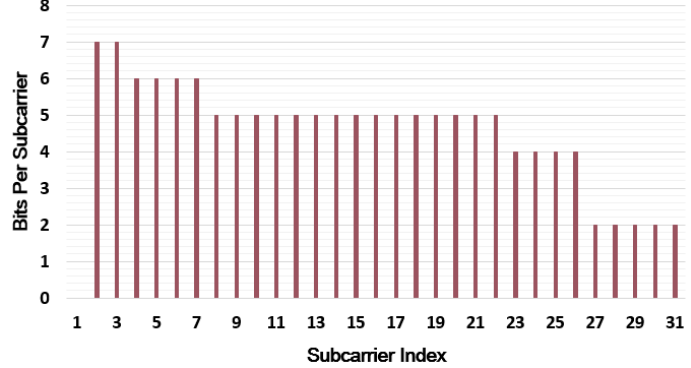
Figure 3. Subcarrier bit allocation profile for orthogonal frequency division multiplexing (OFDM) signals.